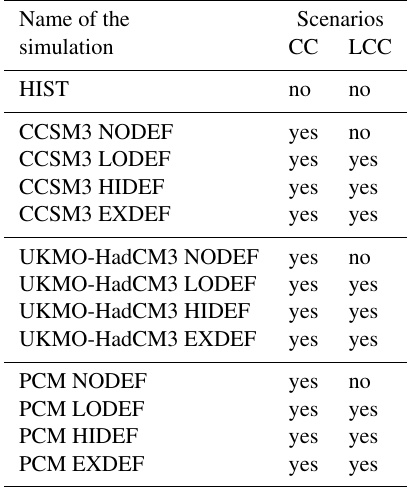
Table 2. List of the different simulations performed with the three LSMs (ORCHIDEE, INLAND-DGVM and LPJmL-DGVM) with or without climate change (CC) and land-cover change